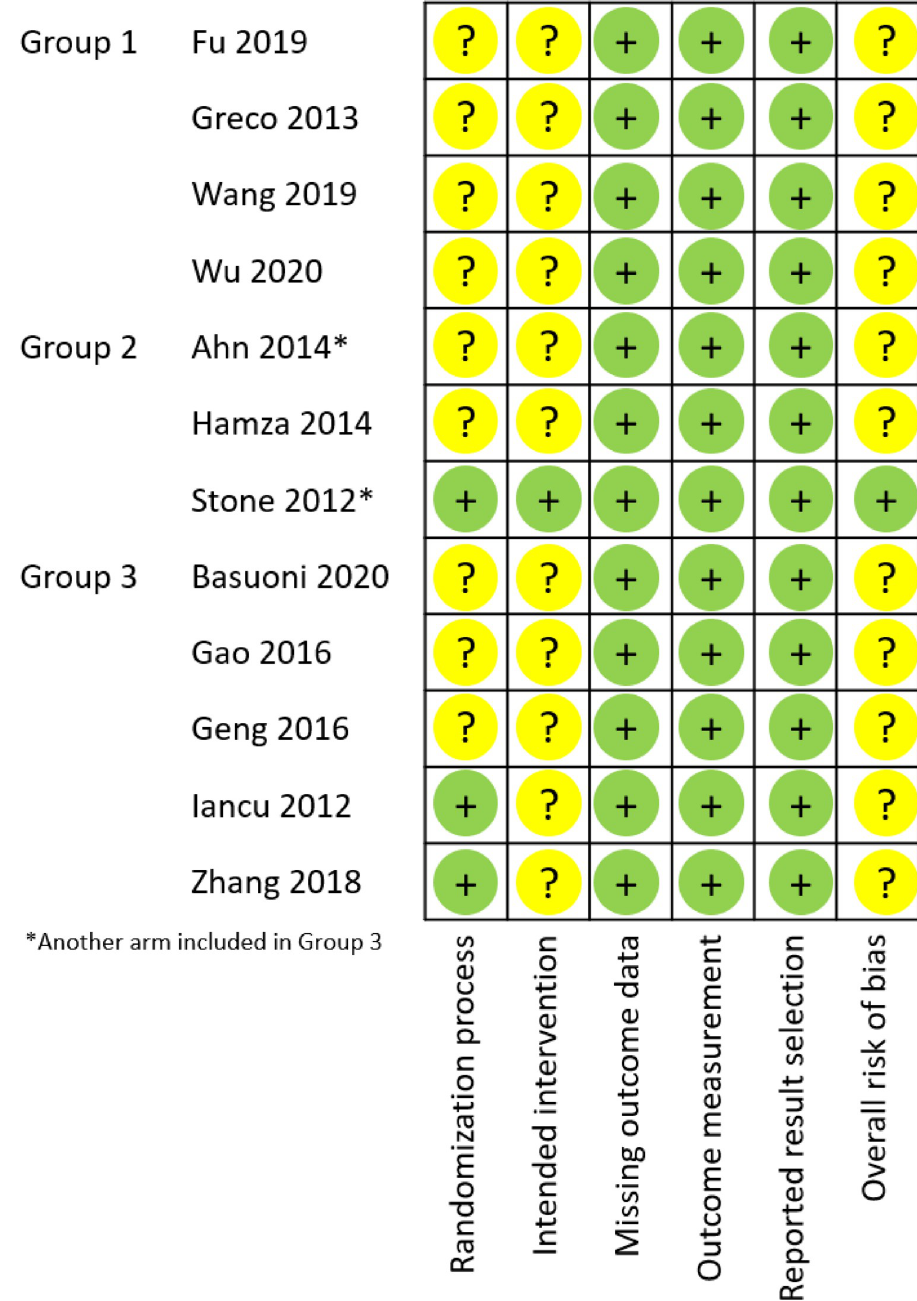
term (i.e., one- or two-year) [92, 96, 98–100]. In addition to correlation with MACE and hospi- talization for heart failure [15, 96, 97, 100]. Improvement in epicardial flow indicated by TIMI